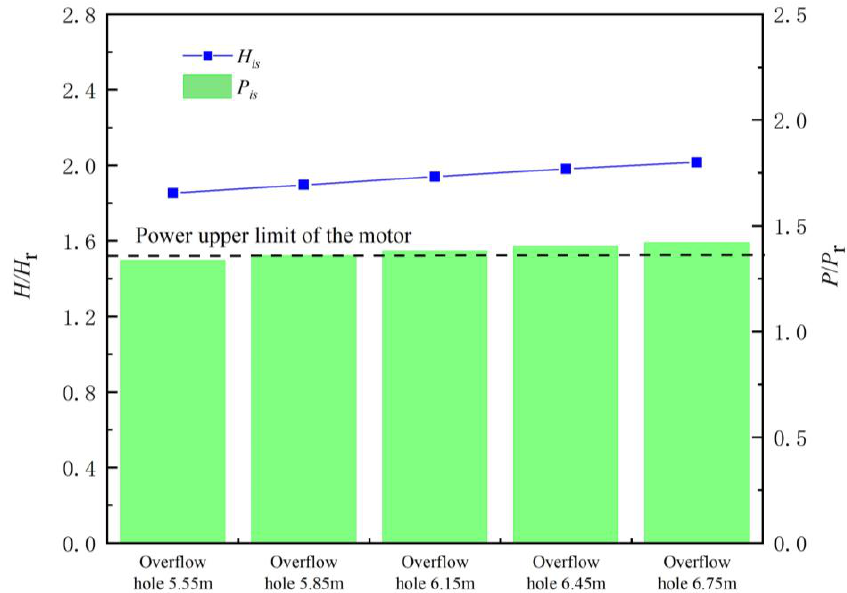
Figure 17. H is and P is of LAPS with OVHO and restricted FLVA under gate refusal working opera- tions.